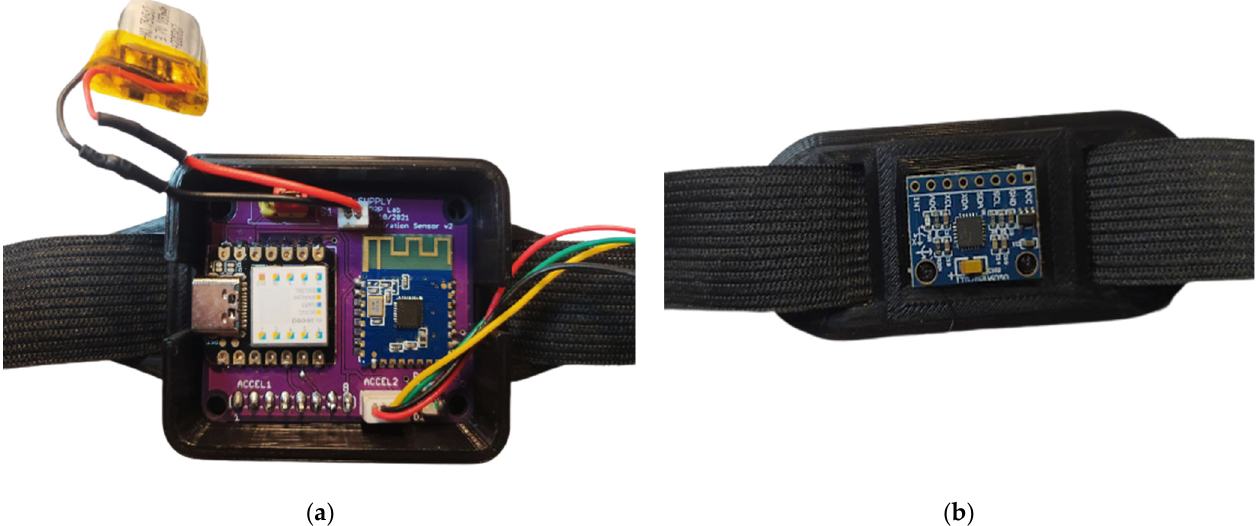
Figure 4. Pictures of the developed chest band: top view ( a ) of the electronic acquisition and processing section; rear ( b ) IMU mounted on proper support.